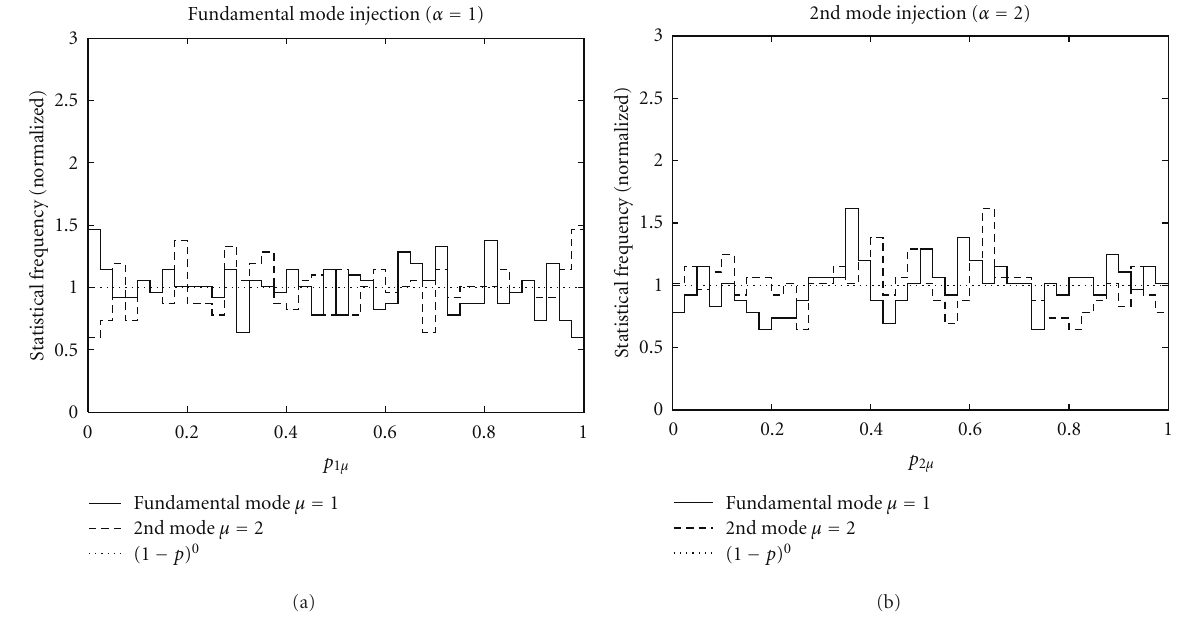
Figure 15: The frequency distribution for the fraction of each propagating mode in the transmission current for the fundamental mode √ incidence; Kd = 20 π , (cid:4) B = 4.